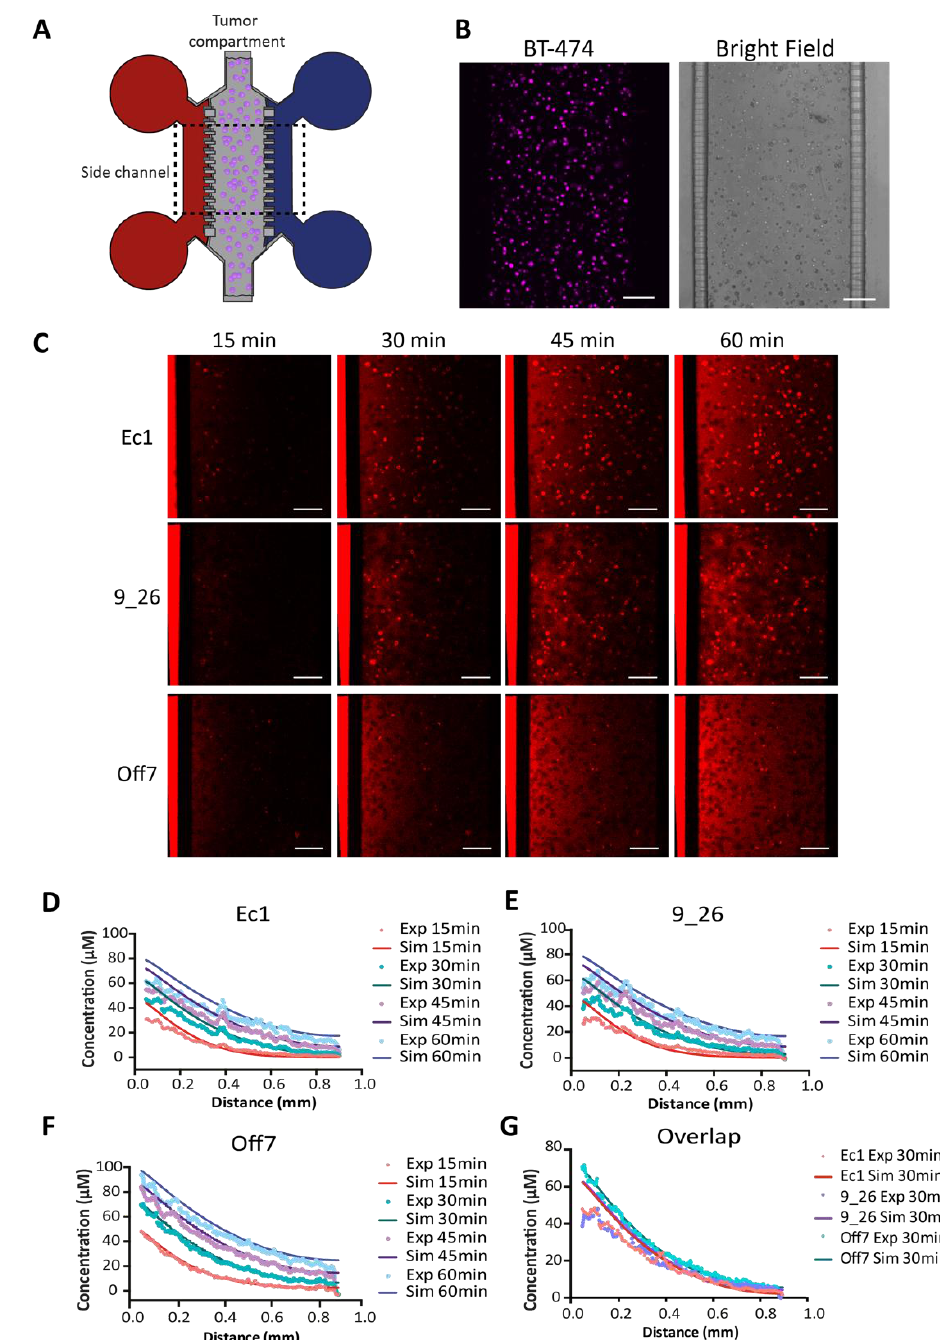
Figure 4. Real-time penetration of DARPins in a tumor-on-a-chip. ( A ) Schematic of the tumor-on- a-chip consisting of a main chamber with BT-474 tumor cells embedded in Matrigel and two side channels connected to medium reservoirs where DARPins (in red) are added to one of the side channels. ( B ) Microscopy images of the BT-474 cells stained with CellTrace violet and a bright-field image of the PDMS chip showing the tumor compartment filled with tumor cells embedded in Matrigel, the side channels, and the microchannels connecting the tumor compartment with the side channels. ( C ) Time points extracted from confocal time-lapse imaging of Alexa Fluor 680-labeled DARPins penetrating in real-time in the tumor tissue in the microfluidic device. Scale bar: 200 µm. ( D – F ) Depiction of simulated vs. experimental data for each DARPin and time point. The diffusion coefficient was fitted for Off7 (see main text). ( G ) Overlap of the experimental and simulated data for the three DARPins at t = 30 min. Exp—experimental data; Sim—simulation data.